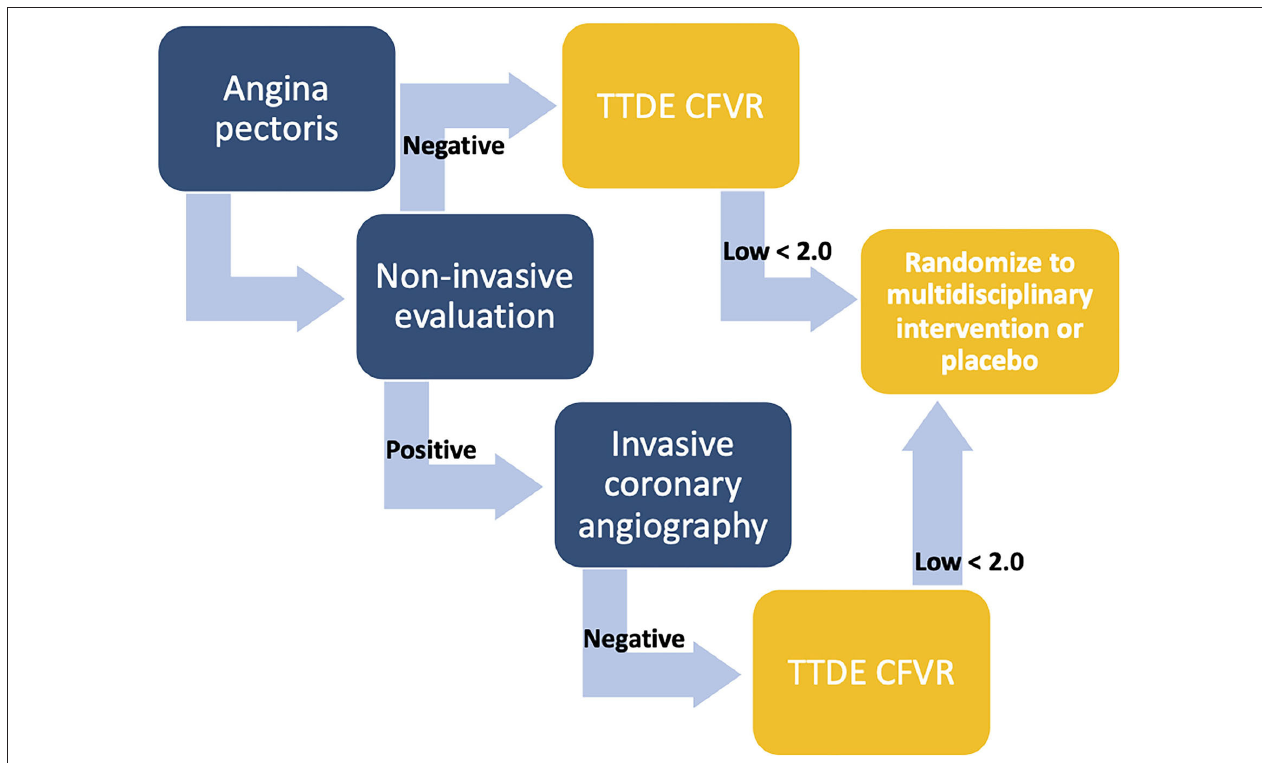
FIGURE 3 | Algorithm illustrating proposed patient cohorts for inclusion in future interventional studies. Coronary flow velocity reserve (CFVR) evaluation in angina patients is suggested either after a negative non-invasive test (functional or anatomical) or following a positive non-invasive test and an invasive coronary angiography with no significant stenosis. In case of a low CFVR, e.g., < 2, participation in a randomized placebo-controlled intervention study is suggested. CFVR, coronary flow velocity reserve; TTDE, transthoracic Doppler